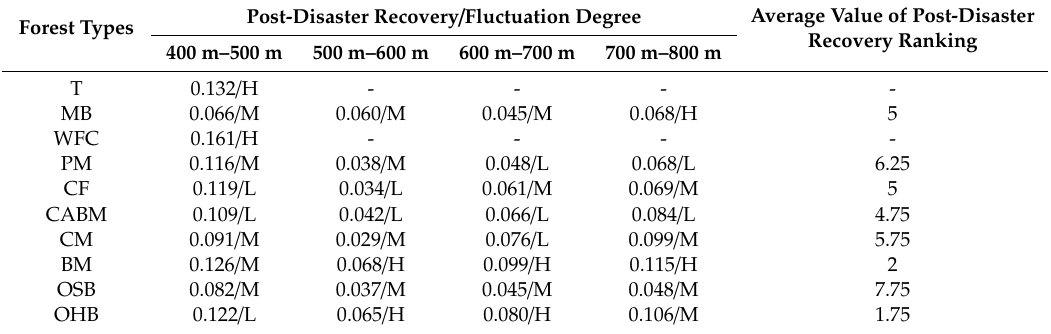
Table 9. Post-disaster recovery and fluctuation degree analysis results for di ff erent forest types in four elevation zones.